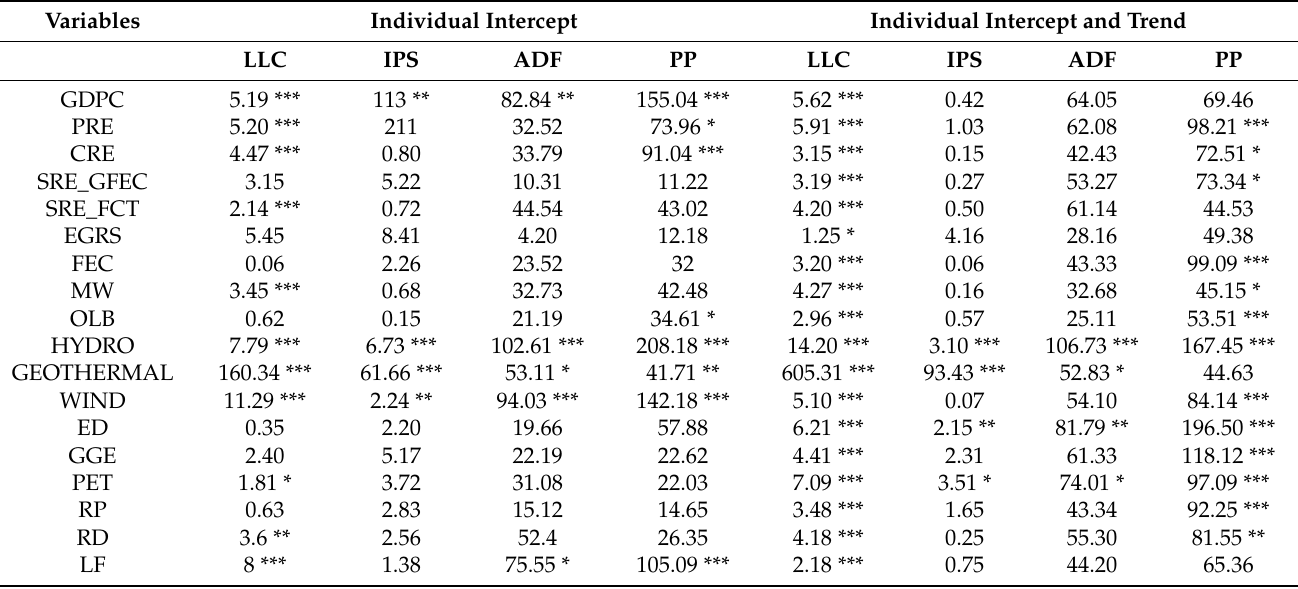
Table 3. Co-integration (on level).